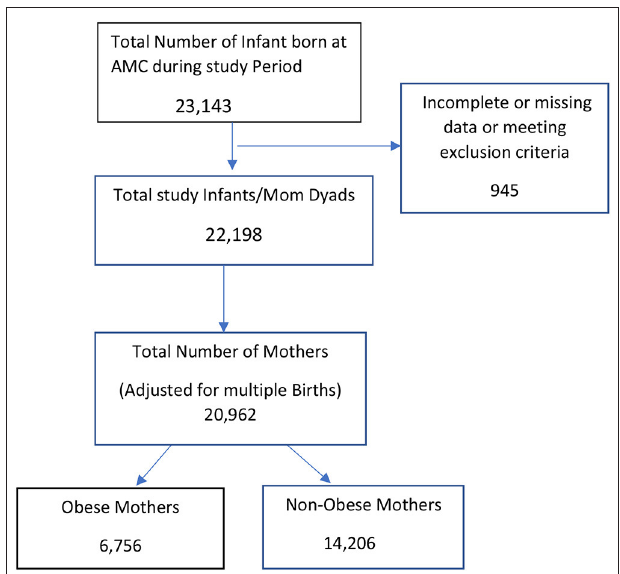
FIGURE 1 | Case flow